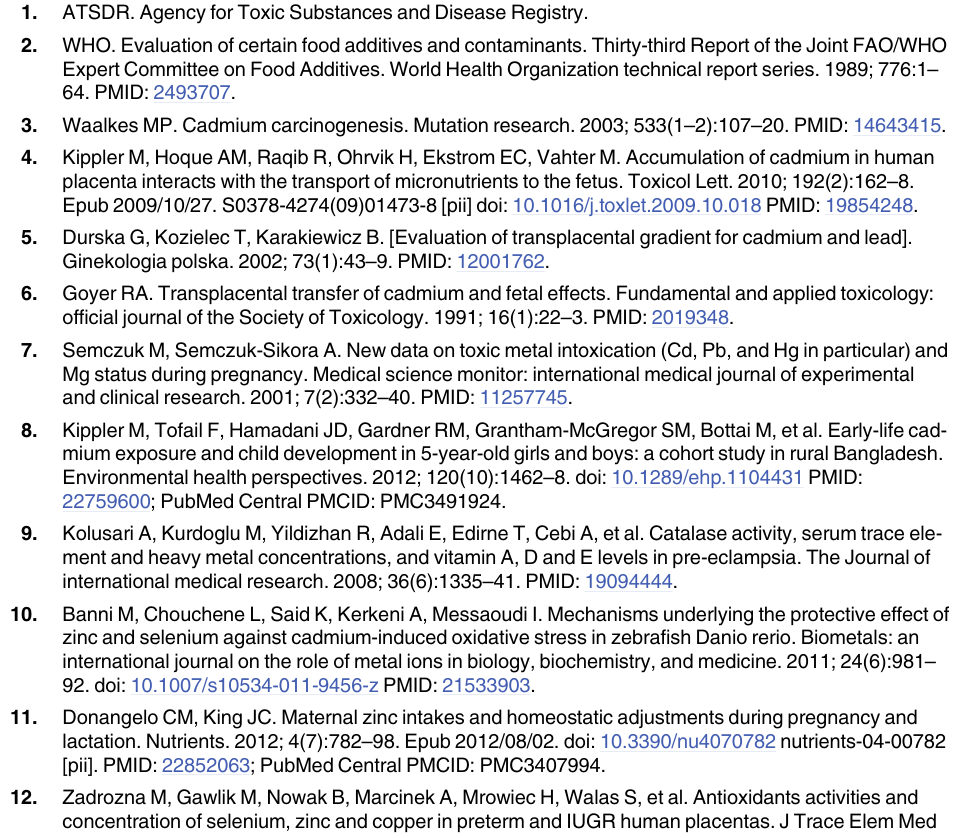
S1 Table. Placental Cd levels (ng/g) of controls (normotensives) and cases (preeclamptics) based on self-reported smoking status both prior to or during pregnancy. S2 Table. Odds ratios and 95% Confidence Intervals (CI) for preeclampsia in relationship to placental Cd and interactive models for essential metals Se or